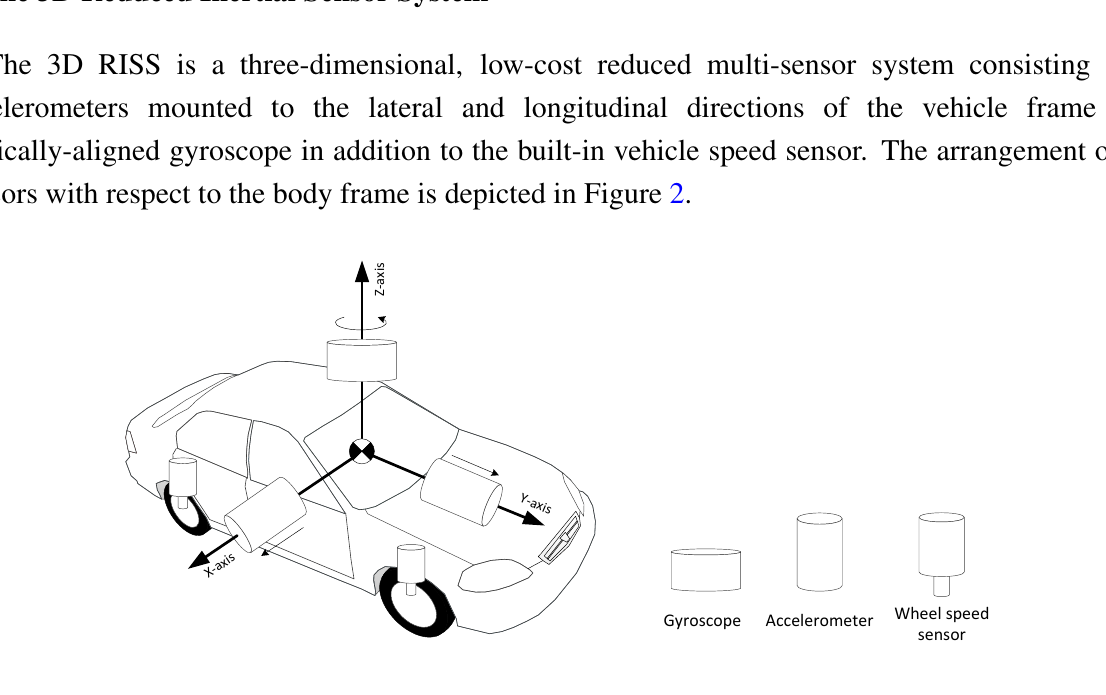
Figure 2. Arrangement of 3D reduced inertial sensor system (RISS) sensors with respect to the body